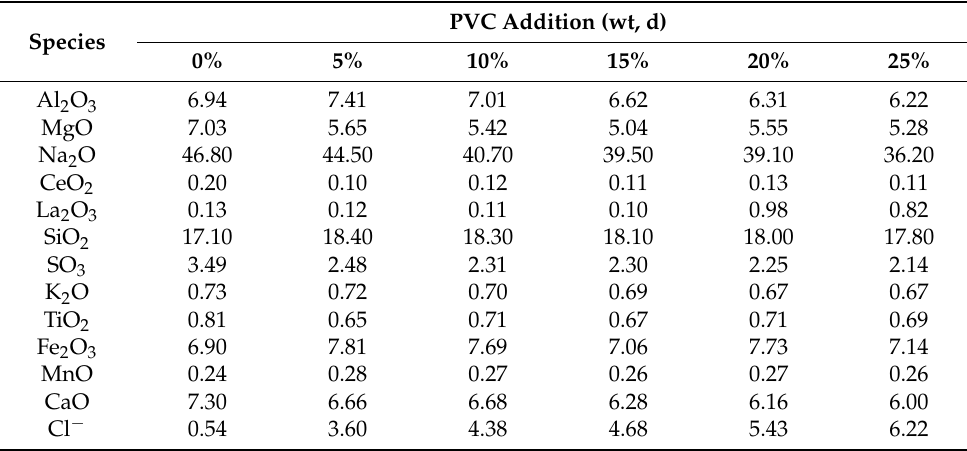
Table 5. Content of chemical compounds and chlorine in the char.